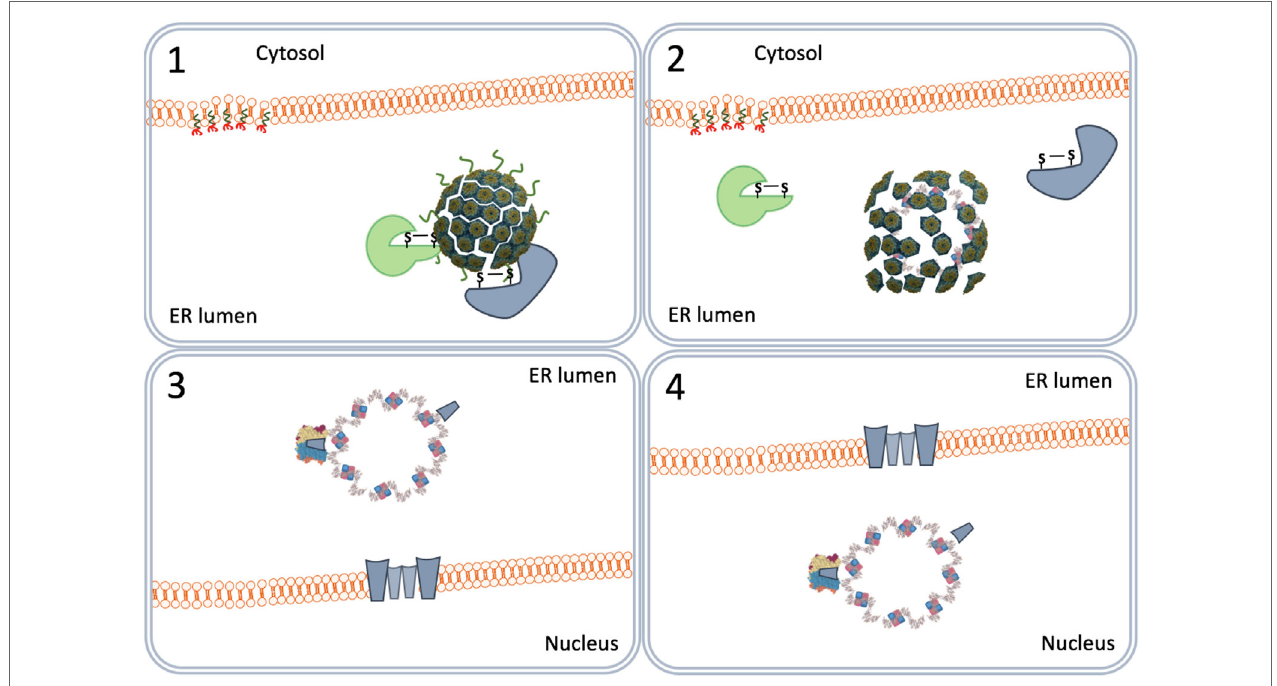
FigURe 6 | Nuclear entry by viroporins. The virus particles destabilized by the endoplasmic reticulum-associated degradation system (1) form VP2 and VP3 viroporins (2) on the inner nuclear membrane (3) that pull the viral genomes into the nucleus